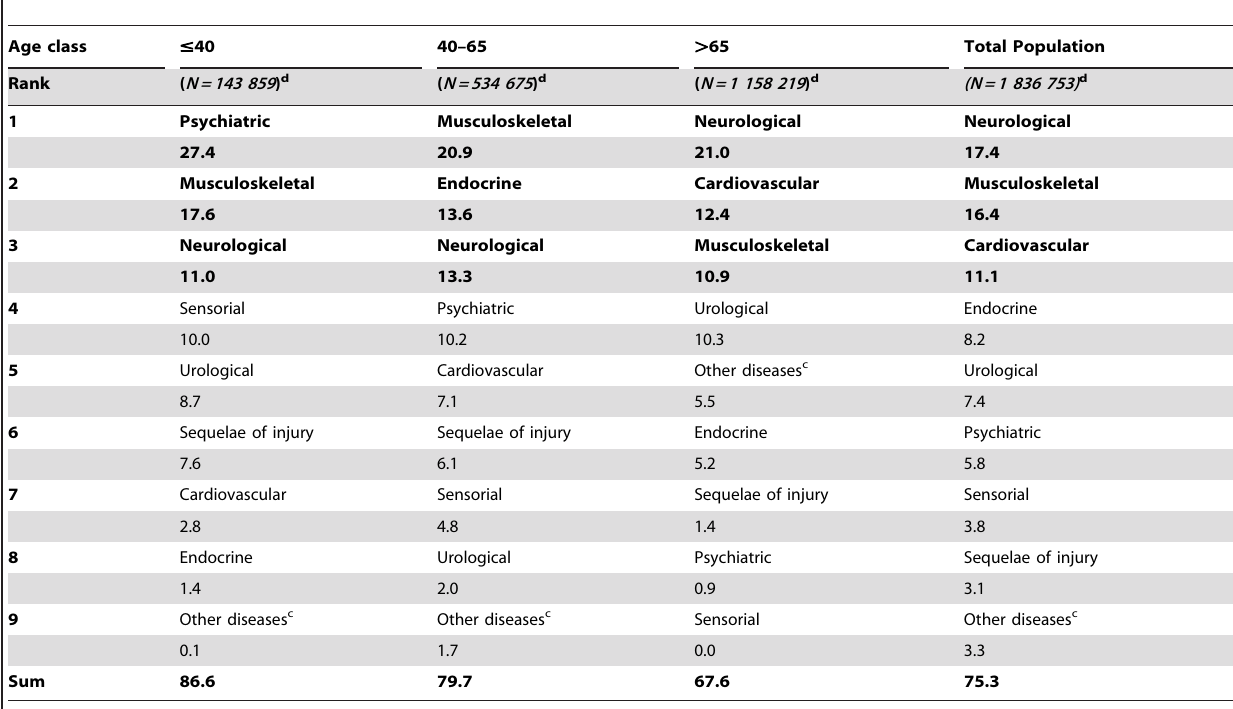
Table 4. Average attributable fraction a (AAF) estimates (%) for each chronic disorder for disability b in